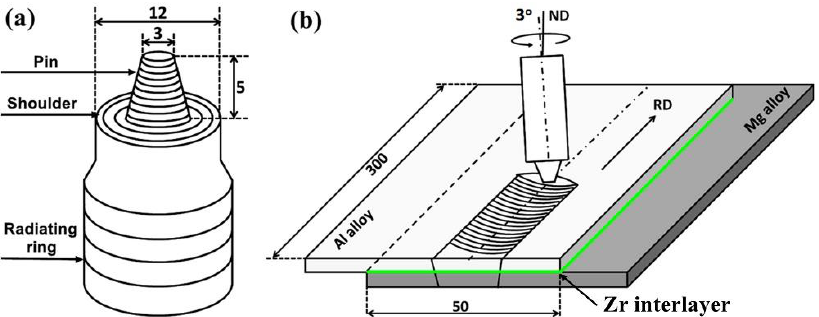
Figure 1. Schematic diagrams of ( a ) the friction stir welding (FSW) tool and ( b ) the welding process.